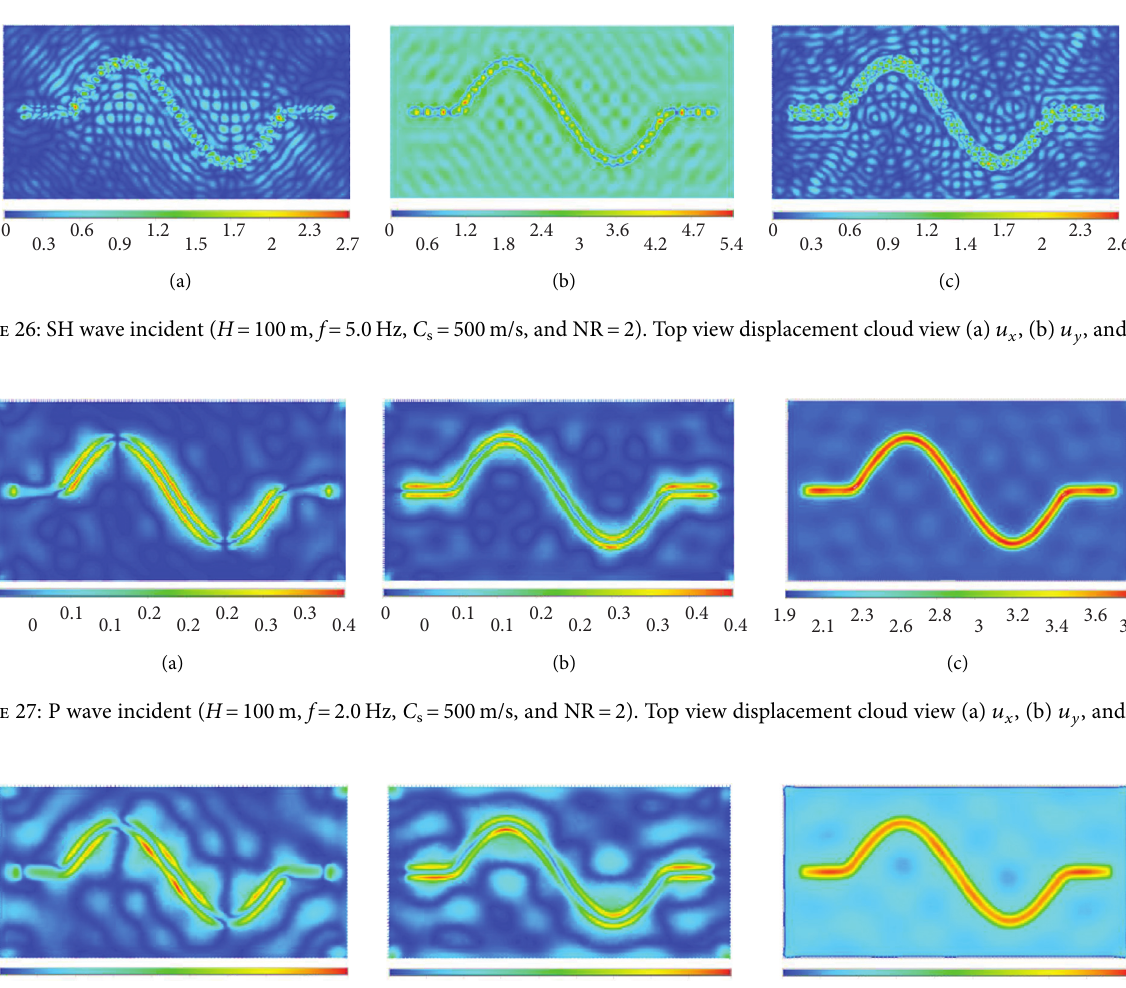
� 500m/s, and NR � 2). Top view displacement cloud view (a) u s